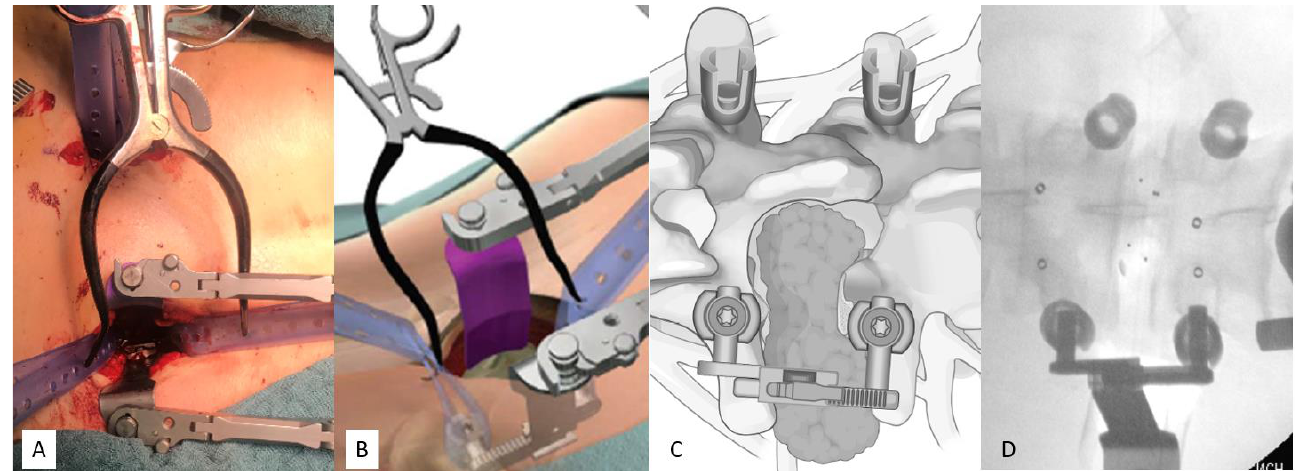
Figure 2. Intraoperative setting of the minimally invasive facetectomy approach. After percutaneous insertion of the pedicle screws, the trans muscular retraction device is connected to the pedicle screws ( A , B ). Via this posterolateral approach laminotomy and facetectomy allow for complete visualization and resection of the dumbbell tumor ( C ). ( D ) demonstrates an intraoperative fluoroscopy. In the facet-sparing cohort, tumor resection was performed via ipsilateral hemilaminec- tomy via a Caspar retraction device (B. Braun, Tuttlingen, Germany). The paraspinal